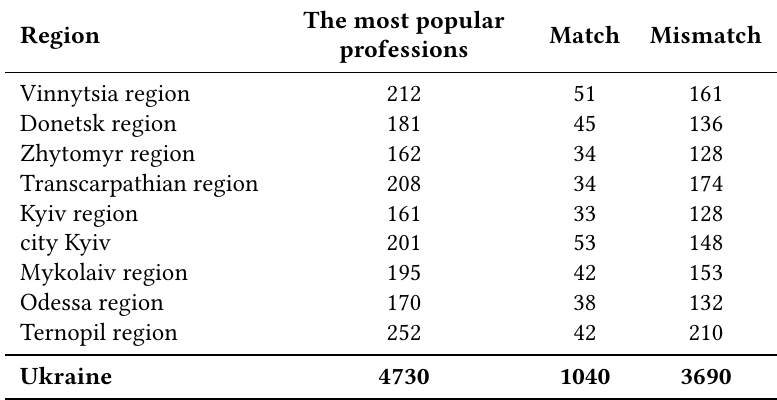
Table 1 Compliance of admission in 2021 with the requirements of the labor market (based on [21]). The most Region